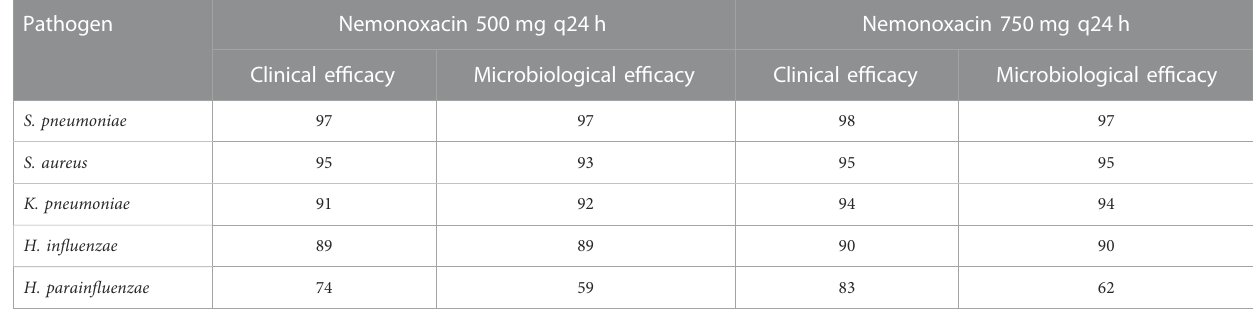
TABLE 5 Cumulative fraction of response of nemonoxacin PK/PD